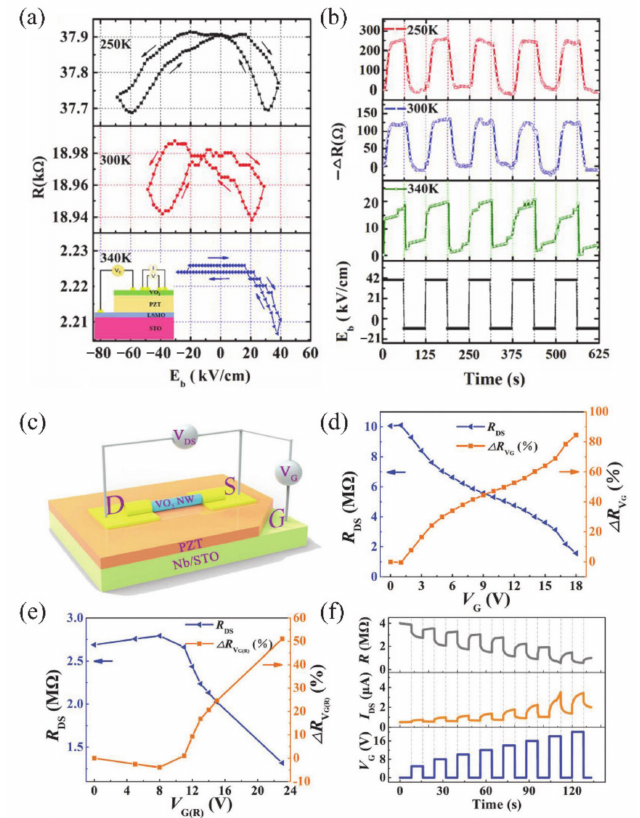
Figure 20. ( a ) Continuous and ( b ) pulsed gate electric field dependences of the resistance in a VO 2 thin film under 250, 300 and 340 K; the inset of ( a ) shows the VO 2 /ferroelectric heterostructure device. Reproduced from [145], with permission from AIP Publishing, 2019. ( c ) Schematic diagram of the fabricated VO 2 NW-FeFET. ( d ) The resistance change of the VO 2 NW-FeFET ranging from 0 to 18 V. ( e ) Resistance change of the VO 2 NW-FeFET ranging from V G(R) = 0 to V G(R) = 23 V; here the V G(R) denotes that the gate voltage is applied and then removed. ( f ) Time-dependent current and resistance evolutions of the VO 2 NW channel under a series of gate pulses from 5 to 20 V. Reproduced from [147], with permission from Royal Society of Chemistry,